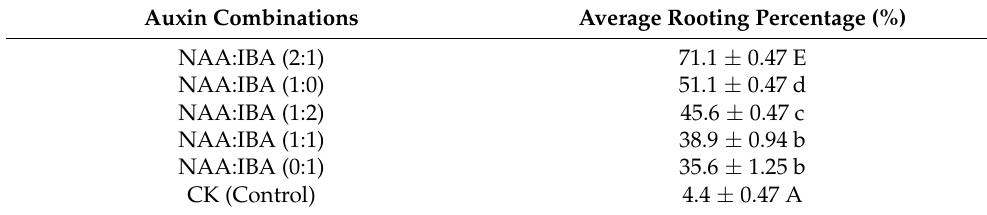
Table 3. Effects of different auxin combinations on rooting percentage of M. wufengensis . Auxin